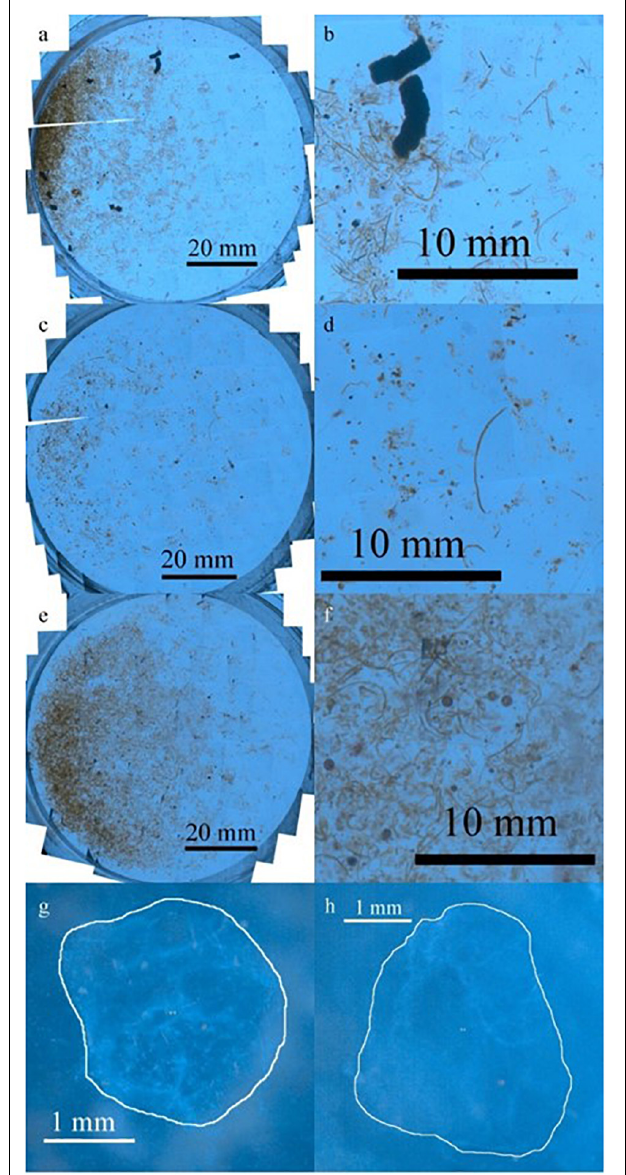
FIGURE 6 | Representative images of particles collected in acrylamide gel sediment traps showing all particles (a,c,e) , or magnified images of a subset of the particles (b,d,f) . Images are from P1706-1, 150 m (a,b) ; P1706-3, 150 m (c,d) ; P1706-4, 50 m (e,f) . (g,h) Show representative images of the porous marine snow aggregates that were seen floating on top of the